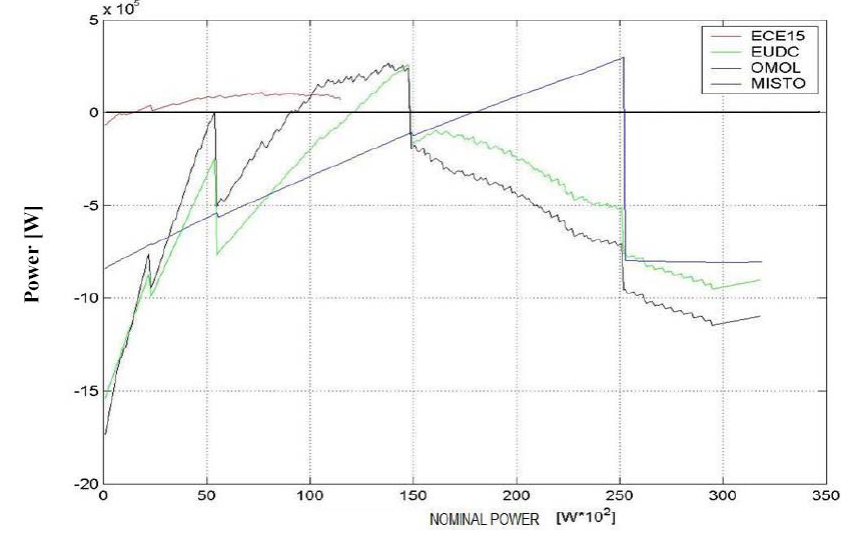
Figure 1. Energy balance as function of installed GT power and track [1].